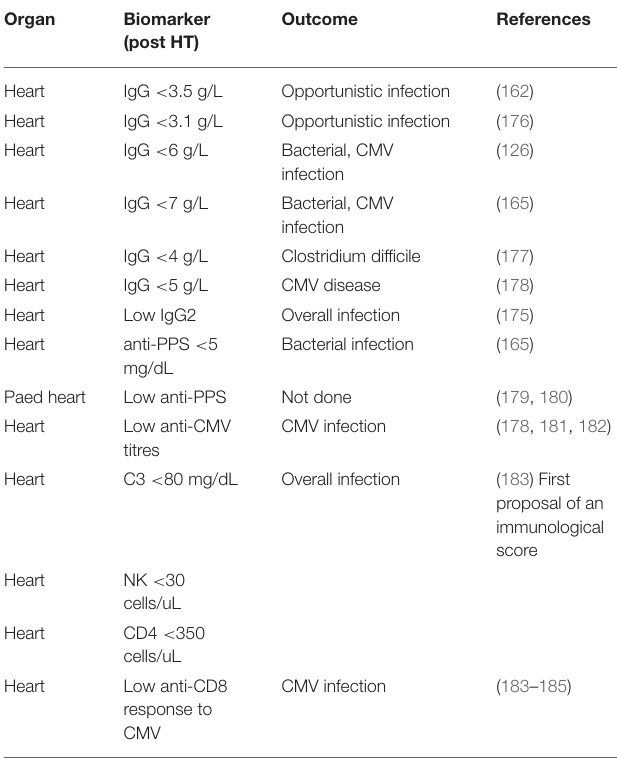
TABLE 2 | Biomarkers used following heart transplantation.